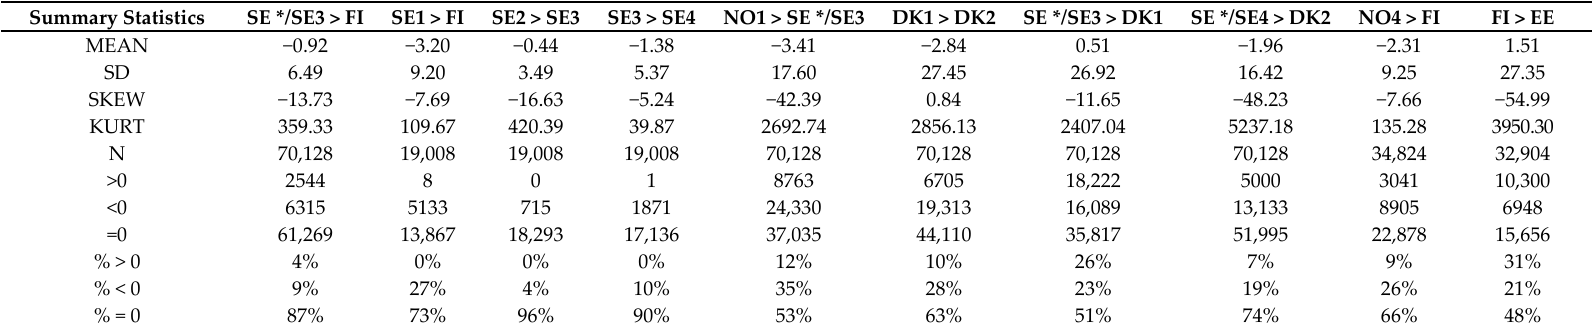
Table A1. Statistical summary of hourly spot price differences between area prices during